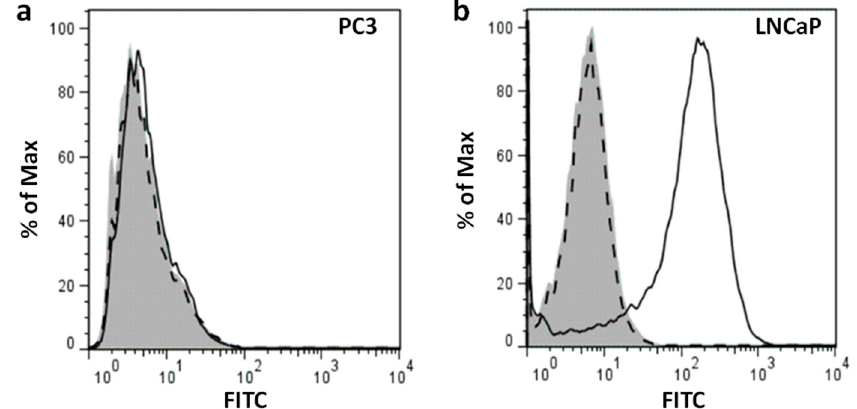
Figure 2. Flow cytometry of PSMA expression in ( a ) PC3 and ( b ) LNCaP cells. Anti-human PSMA antibody conjugated to Alexa Fluor® 488 and corresponding isotype control were used to stain the cells. Unstained cells are shown in gray. Dashed lines indicate the isotype control and solid lines show PSMA-positive cells.